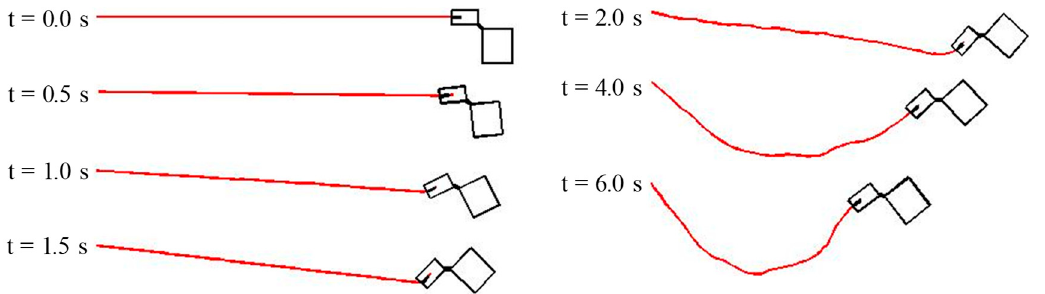
Figure 10. Time history of angle.